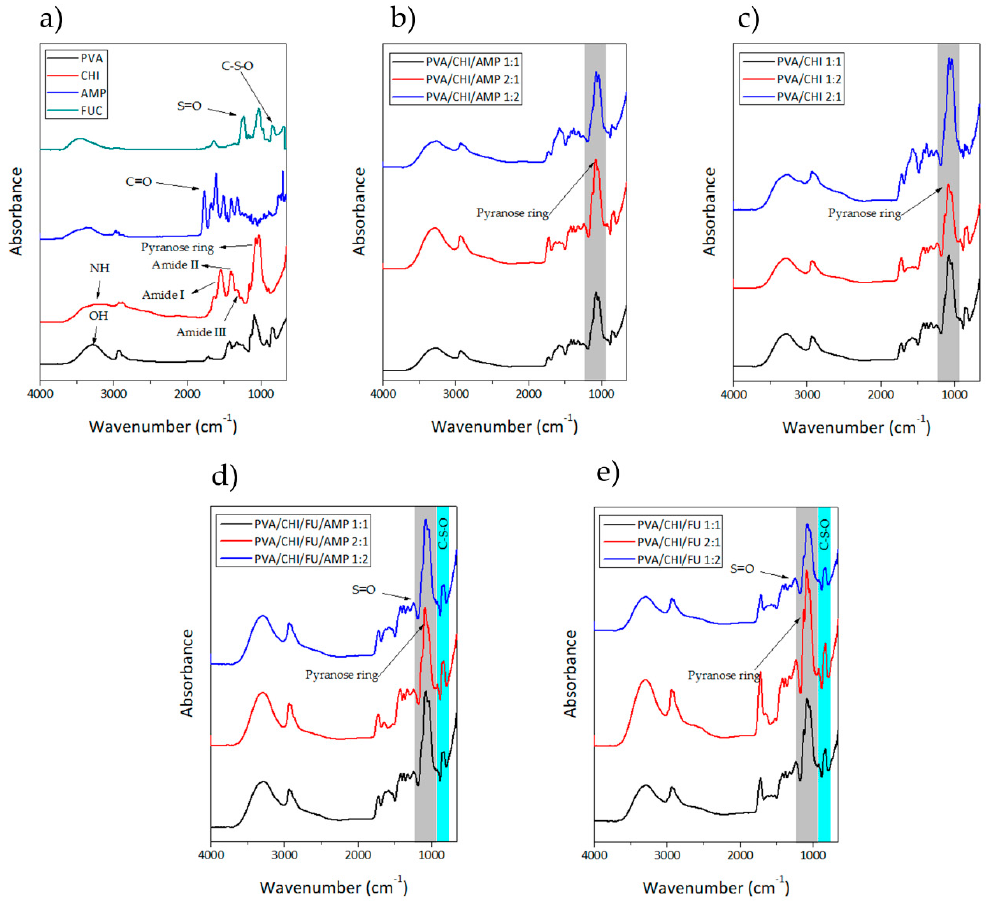
Figure 1. FTIR for the obtained BAPM. ( a ) Row materials; ( b ) PVA / CHI / AMP samples; ( c ) PVA / CHI samples; ( d ) PVA / CHI / FUC / AMP samples; and ( e ) PVA / CHI / FUC samples.